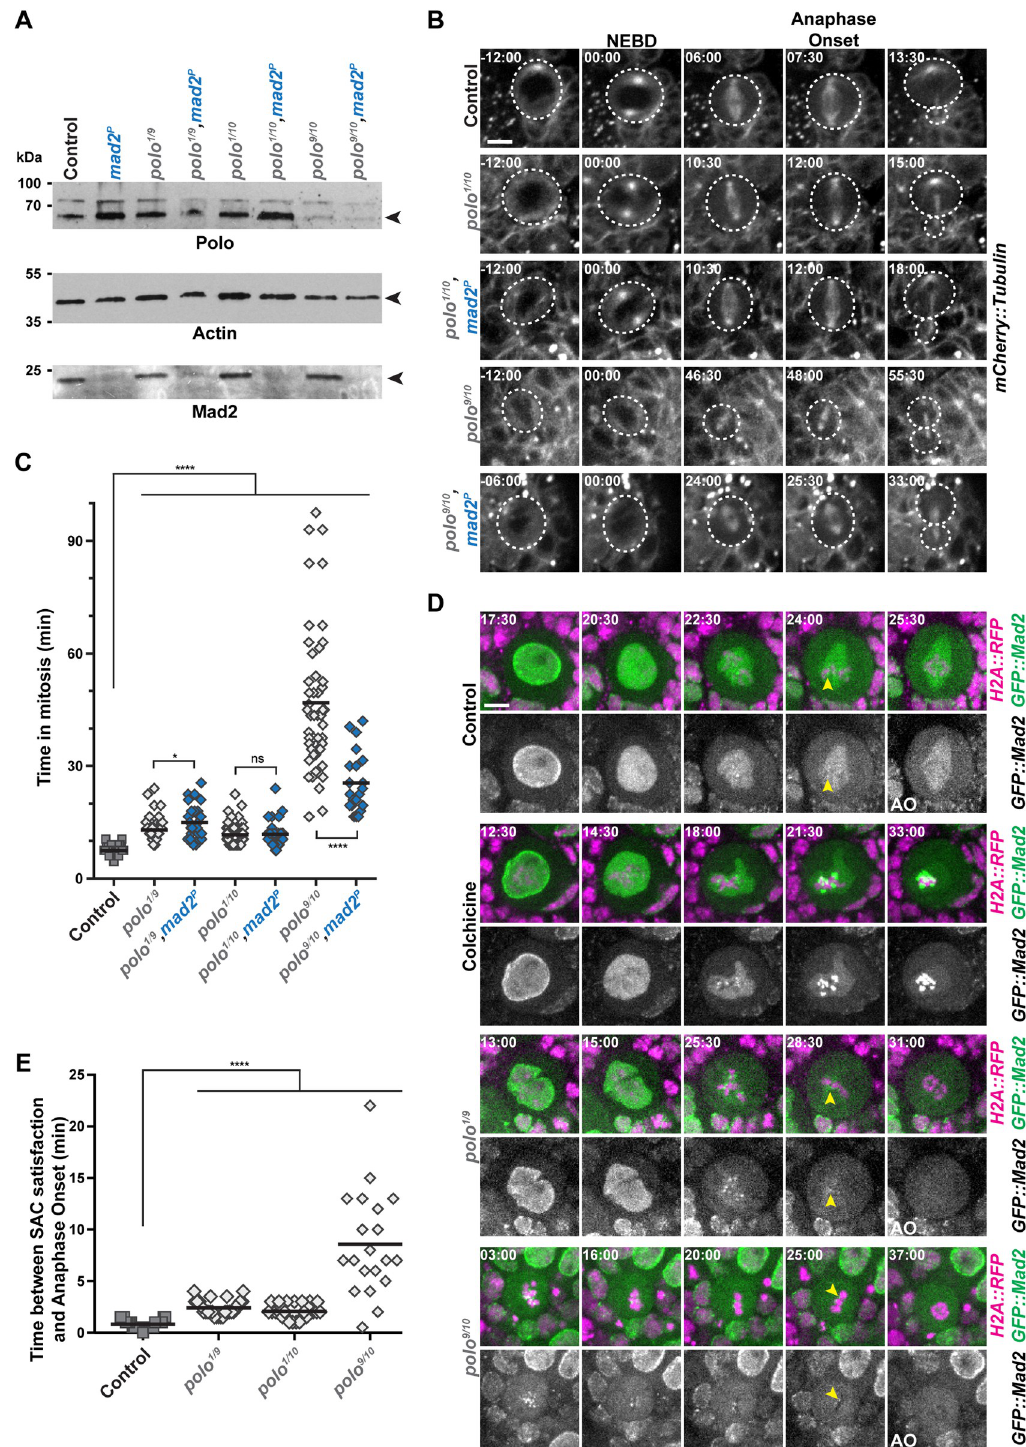
Fig 1. polo mutant NSCs display a SAC-independent mitotic delay. A) Polo, Mad2 and Actin Western blot analyses in polo and polo , mad2 P mutant brain extracts. The genotypes are indicated for each lane. polo 1 /polo 10 and polo 1 /polo 9 are weak hypomorphs and polo 9 /polo 10 is a strong hypomorph. B) Time-lapse imaging of mitosis in polo mutants in the absence or presence of Mad2. Selected image series of dividing NSCs of the indicated genotypes expressing mCherry::Tubulin. The white dashed line outlines the dividing NSCs. Scale bar: 5 μ m. Time is min:s (t = 00:00 is NEBD). C) Quantification of time in